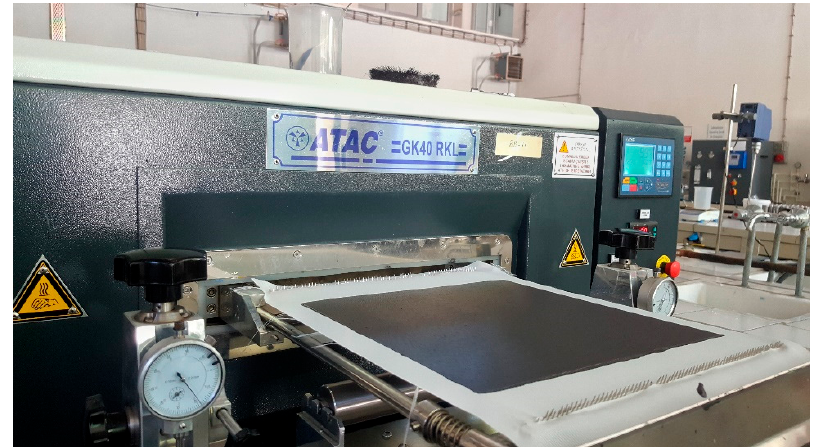
Figure 1. Coating process on Atac GK 40 RKL. Table 5. Fabric codes.